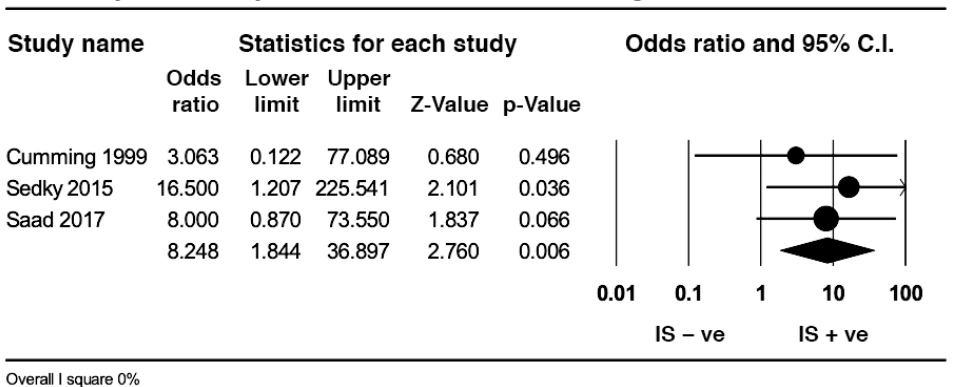
Figure 6. Effect size of the pooled prevalence of the methylenetetrahydrofolate reductase TT in sickle cell disease without and with ischemic stroke. 2.9. Effect Size of Methylenetetrahydrofolate Reductase in Avascular